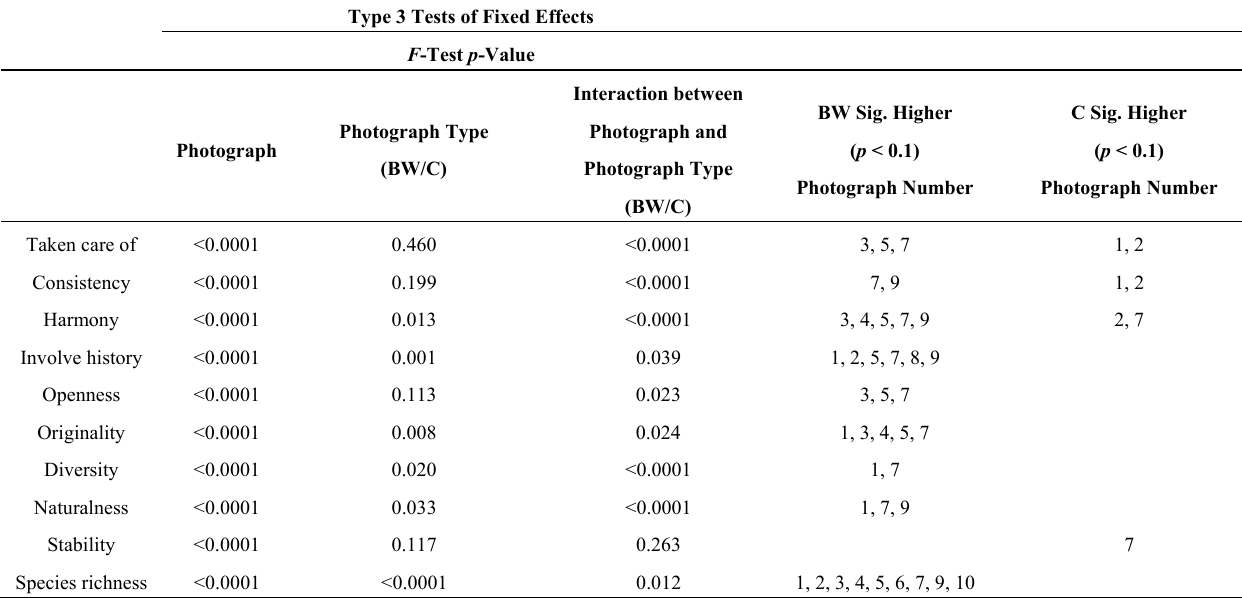
Table 6. Linear mixed model with individual respondent as a random effect: effects of photograph, photograph type (Black-and-white BW, coloured C) and their interaction. Total number of photos =